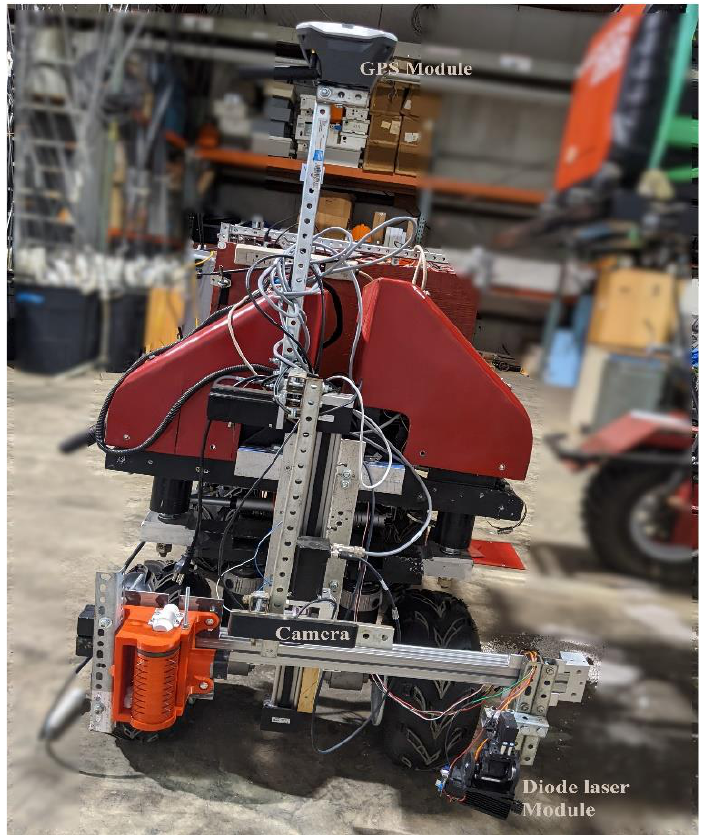
Figure 2. Robotic platform for laser weeding.